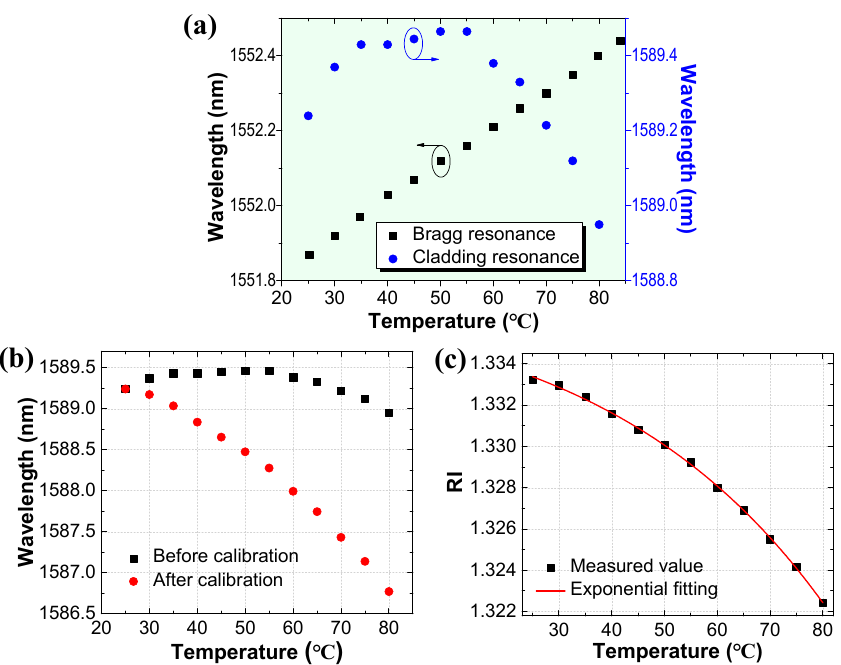
Figure 5. As the temperature increased, ( a ) original wavelength shifts of the Bragg and cladding mode resonances when the hybrid grating is in water; ( b ) the wavelength shifts of the cladding mode resonance before and after temperature calibration; ( c ) variation of the calculated RI with the temperature.